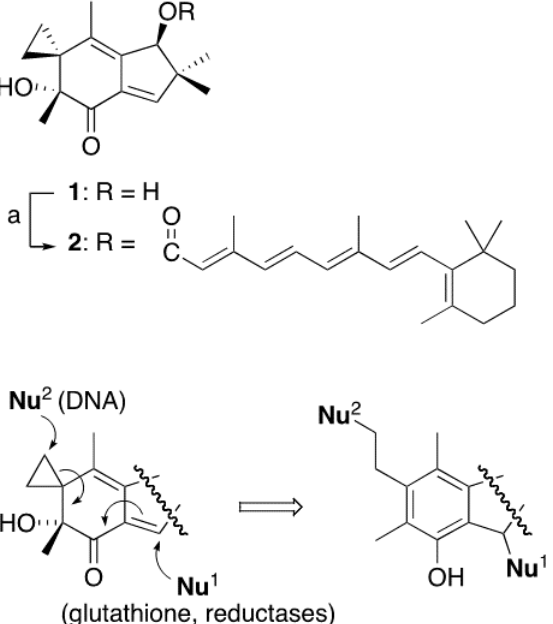
Scheme 1. Synthesis of the retinoate 2 of illudin M ( 1 ) and mechanism of action. Reagents and con-